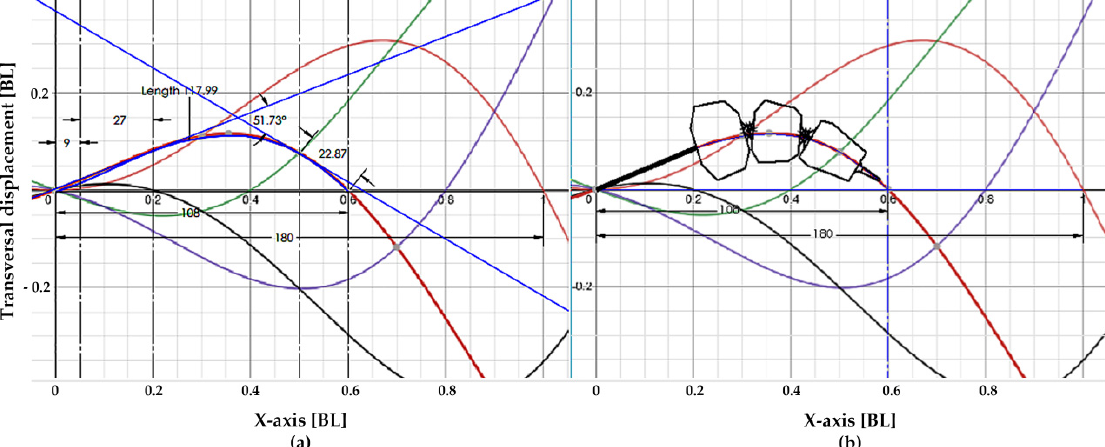
Figure 4. Different colors have been used to draw the midline of the fish body at different instants of Figure 4. ( a ) Finding the maximal angle of deflection corresponding to 52°, ( b ) approximating the time. The used tail beat frequency is 1 Hz. It has been considered half a period (e.g. 0.5 s). Black curve curve using two joints. For both the abscissae and the ordinate, the unit of measurement was body length (BL). corresponds to 0.1 s, purple curve to 0.2 s, green curve to 0.3 s, red curve to 0.4 s, and orange curve (nearly symmetric to black curve with respect to the x -axis) corresponds to 0.5 s. ( a ) The maximum angle of deflection of the mid line during the waving motion is investigated, and corresponds to 52 ◦ , ( b ) The mid line at its maximum angle of deflection can be well approximated using two joints.